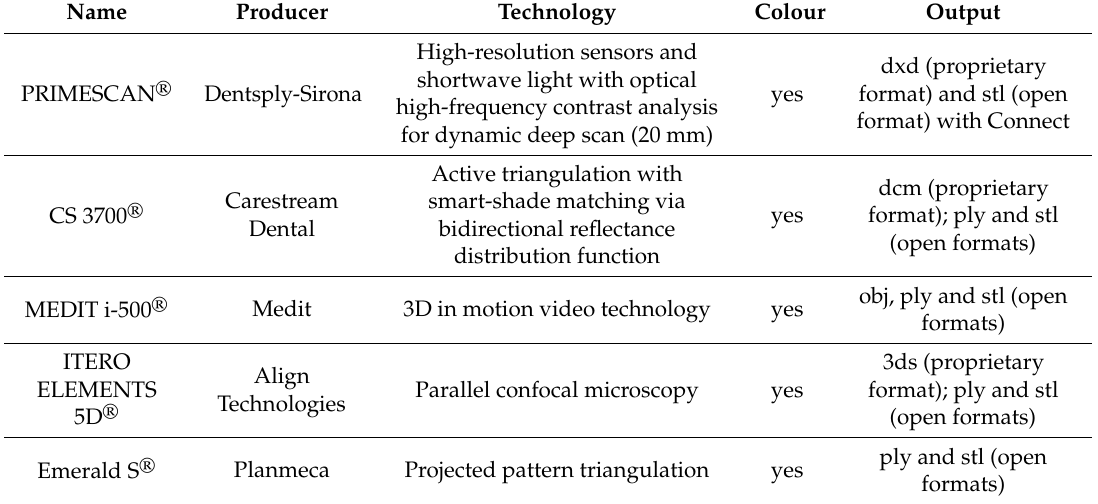
Table 1. Features of the di ff erent intraoral scanners (IOSs) used in this